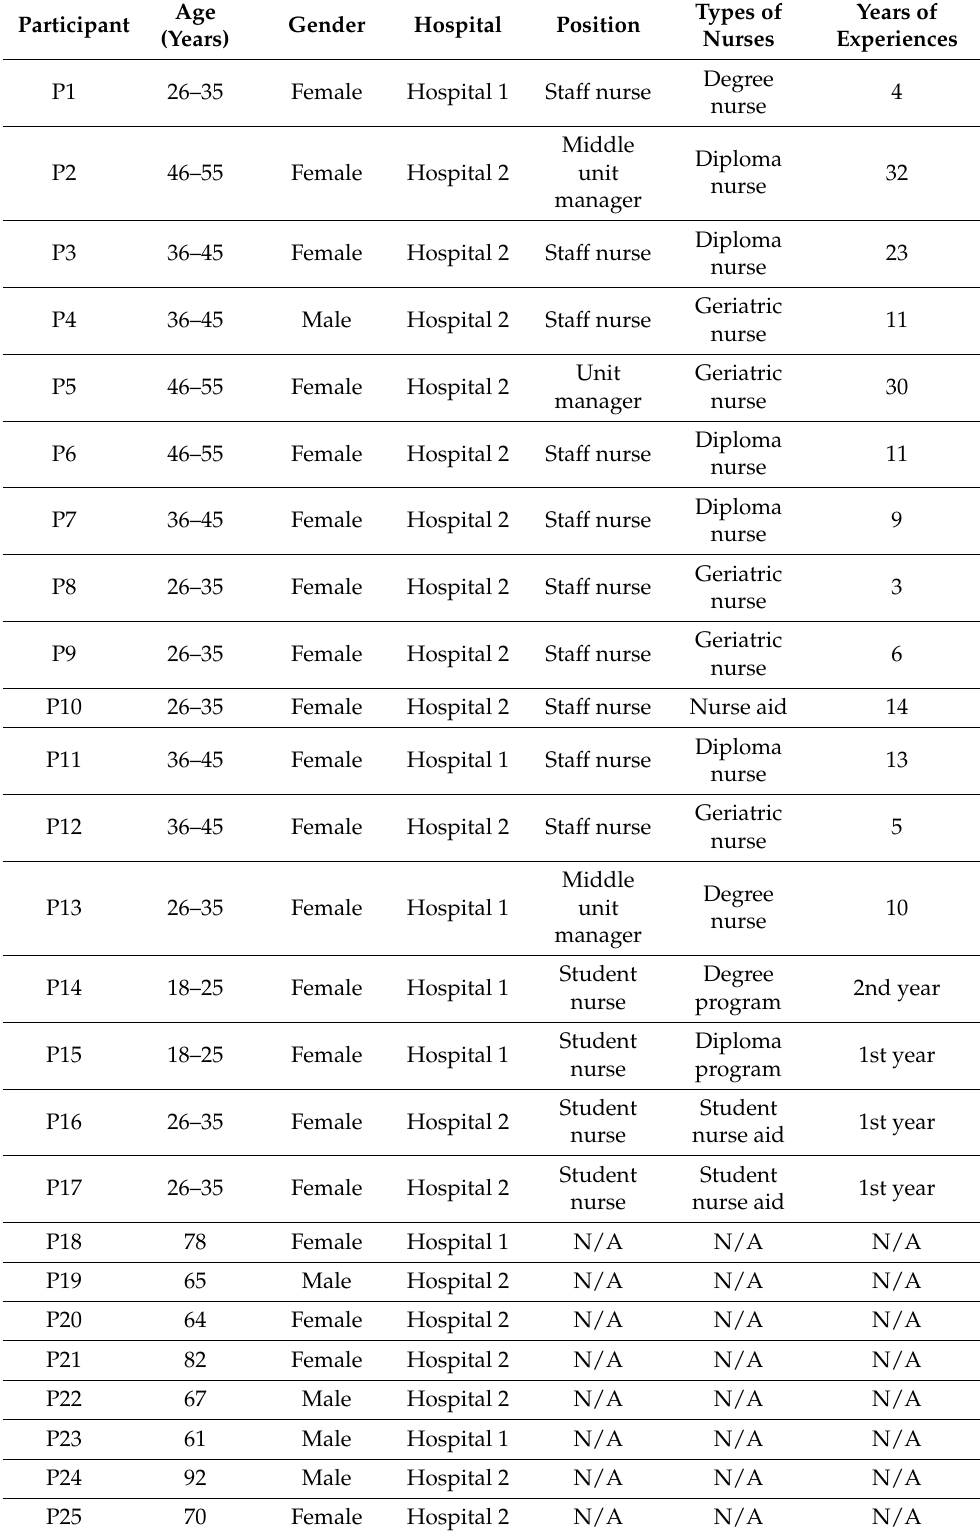
Table 1. Sociodemographic characteristics of the